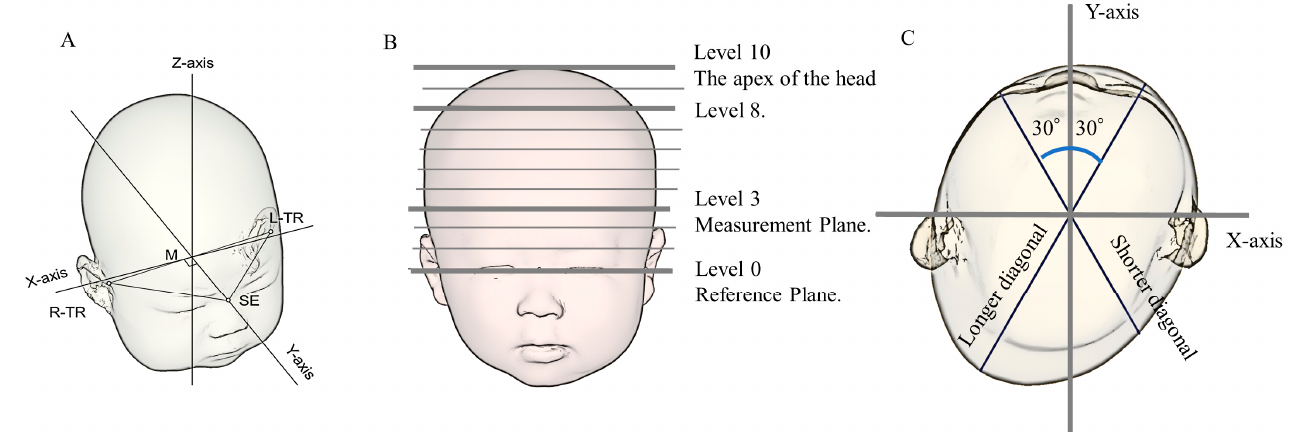
Figure 2. The measurement of each parameter using the 3D scanner. This figure is a modification of the figure created in our previous study [7]. ( A ) Determination of the reference plane (level 0) and X-, Y-, and Z-axes. ( B ) Determination of the measurement plane. ( C ) Cross-sectional view of level 3 of the measurement plane. The X -axis, Y -axis, and 30° diagonals were used to quantify cranial asymmetry and cranial vault asymmetry index. L-TR, left tragion; M, midpoint of both tragions; R-TR, right tragion; SE, sellion; TR, tragion.